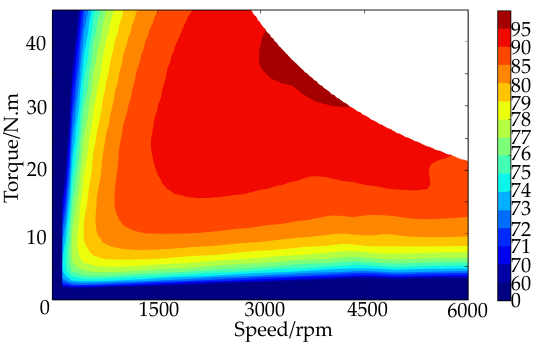
Figure 3. Permanent magnet synchronous generator efficiency map.